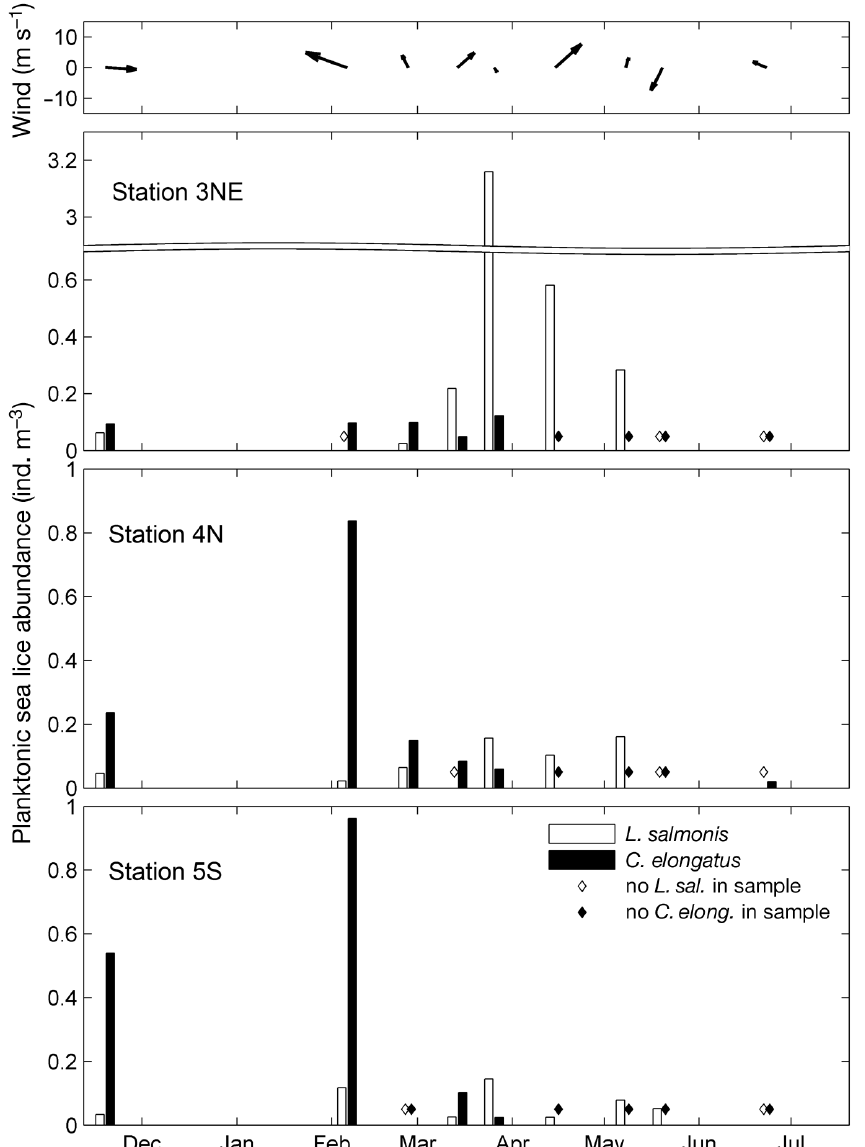
Fig. 5. Lepeophtheirus salmonis (white) and Caligus elongatus (black). Time series of abundance (nauplii and copepodids) in the top meter of the water column at stations 3NE, 4N and 5S. Bars: densities, diamonds: samples with no sea lice. Arrows in uppermost panel: wind direction and speed averaged over 12 h prior to the field